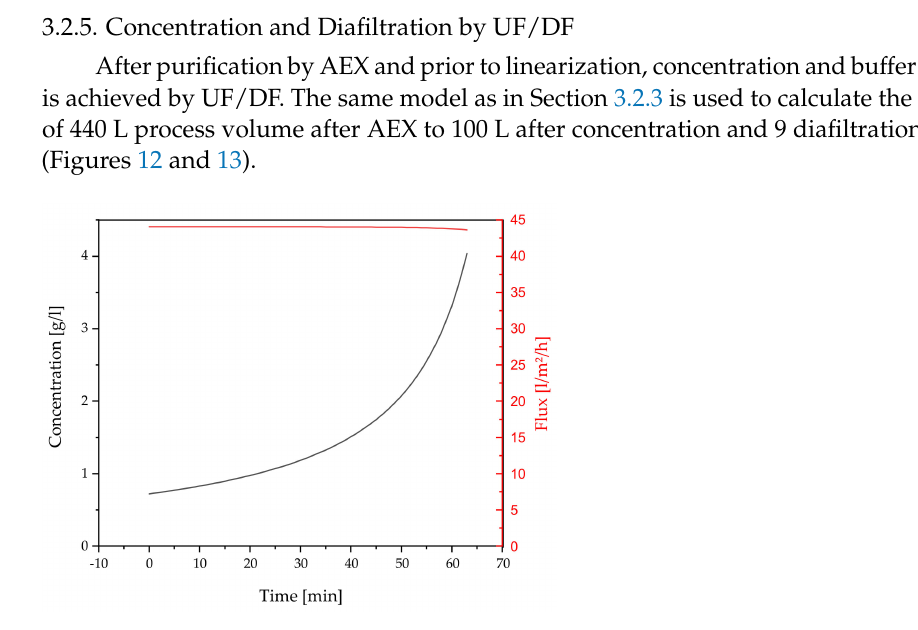
Figure 12. Initial 9 × concentration prior to addition of diafiltration buffer and final concentration. Filtration is performed at a constant flux. This results in an exponential increase of the concentration. A 9-fold increase in concentration is achieved after 60 min.